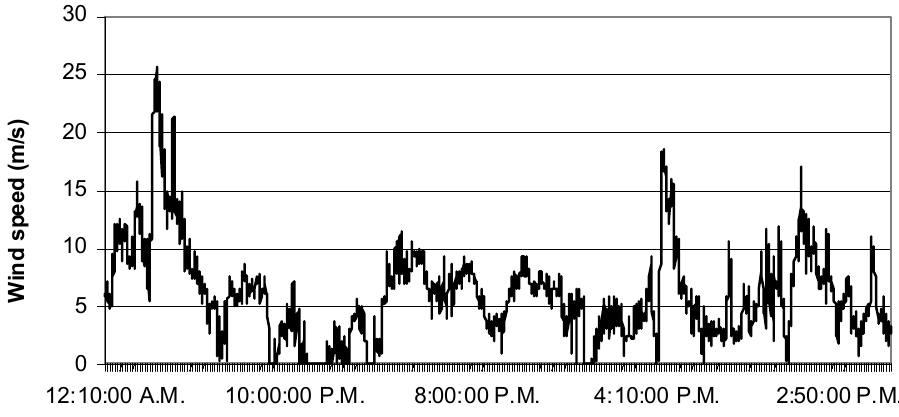
Figure 2. Wind speed variation during the one month monitoring period.